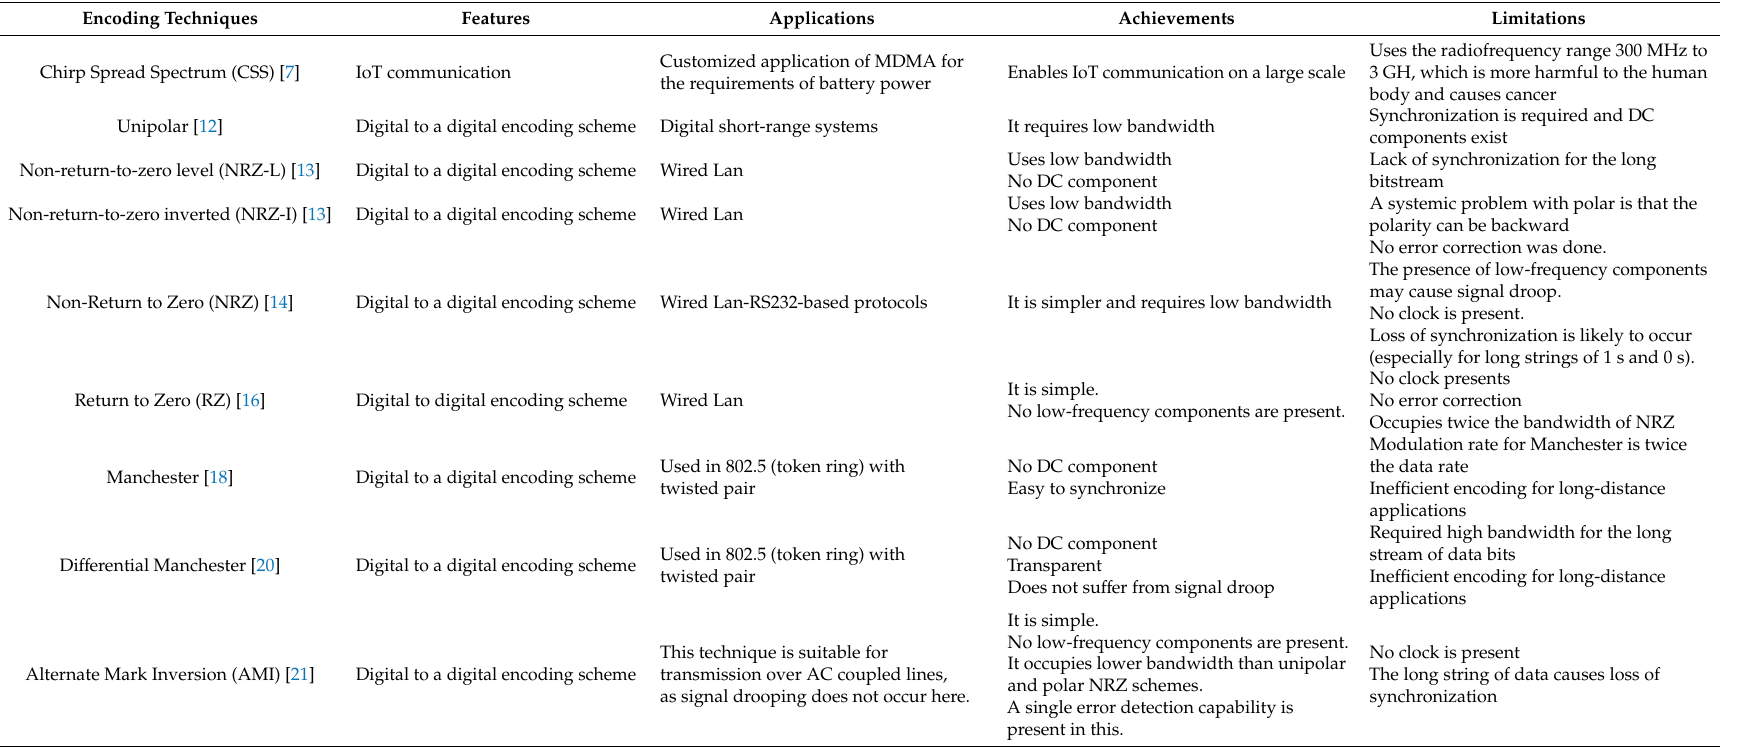
Table 1. Related work summary against the benchmark